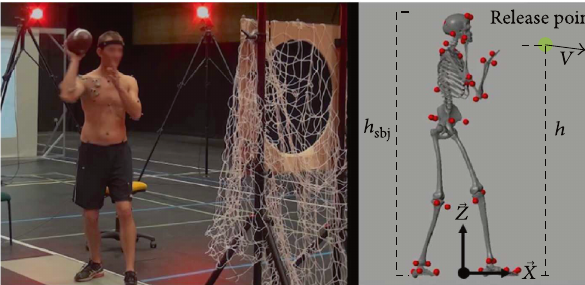
Figure 4: Subject at release time and corresponding task space features. The features consist of the hand release height and the hand velocity of release. Marker occlusion prevented the de fi nition of the angle of release as a reliable